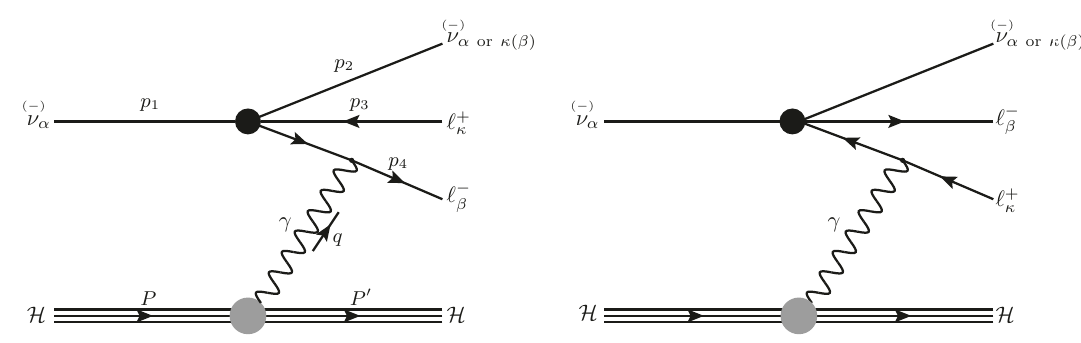
Figure 1 . Diagrams contributing to the neutrino trident process in the four-point interaction limit of the Standard